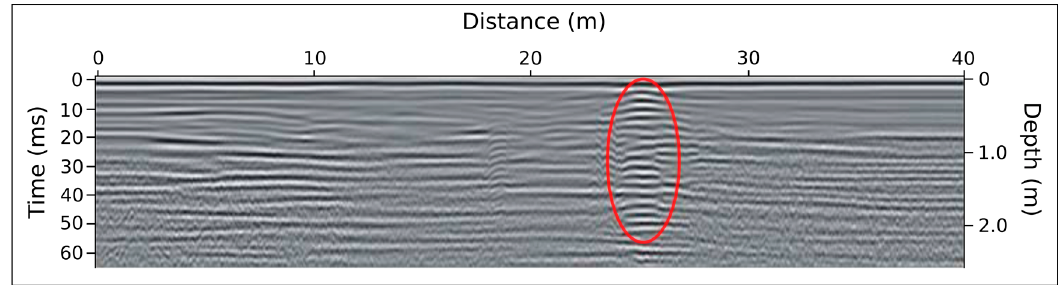
Figure 5 . Radargram indicating a potential water-filled feature beneath a car-park in South Africa (with permission from [59]).